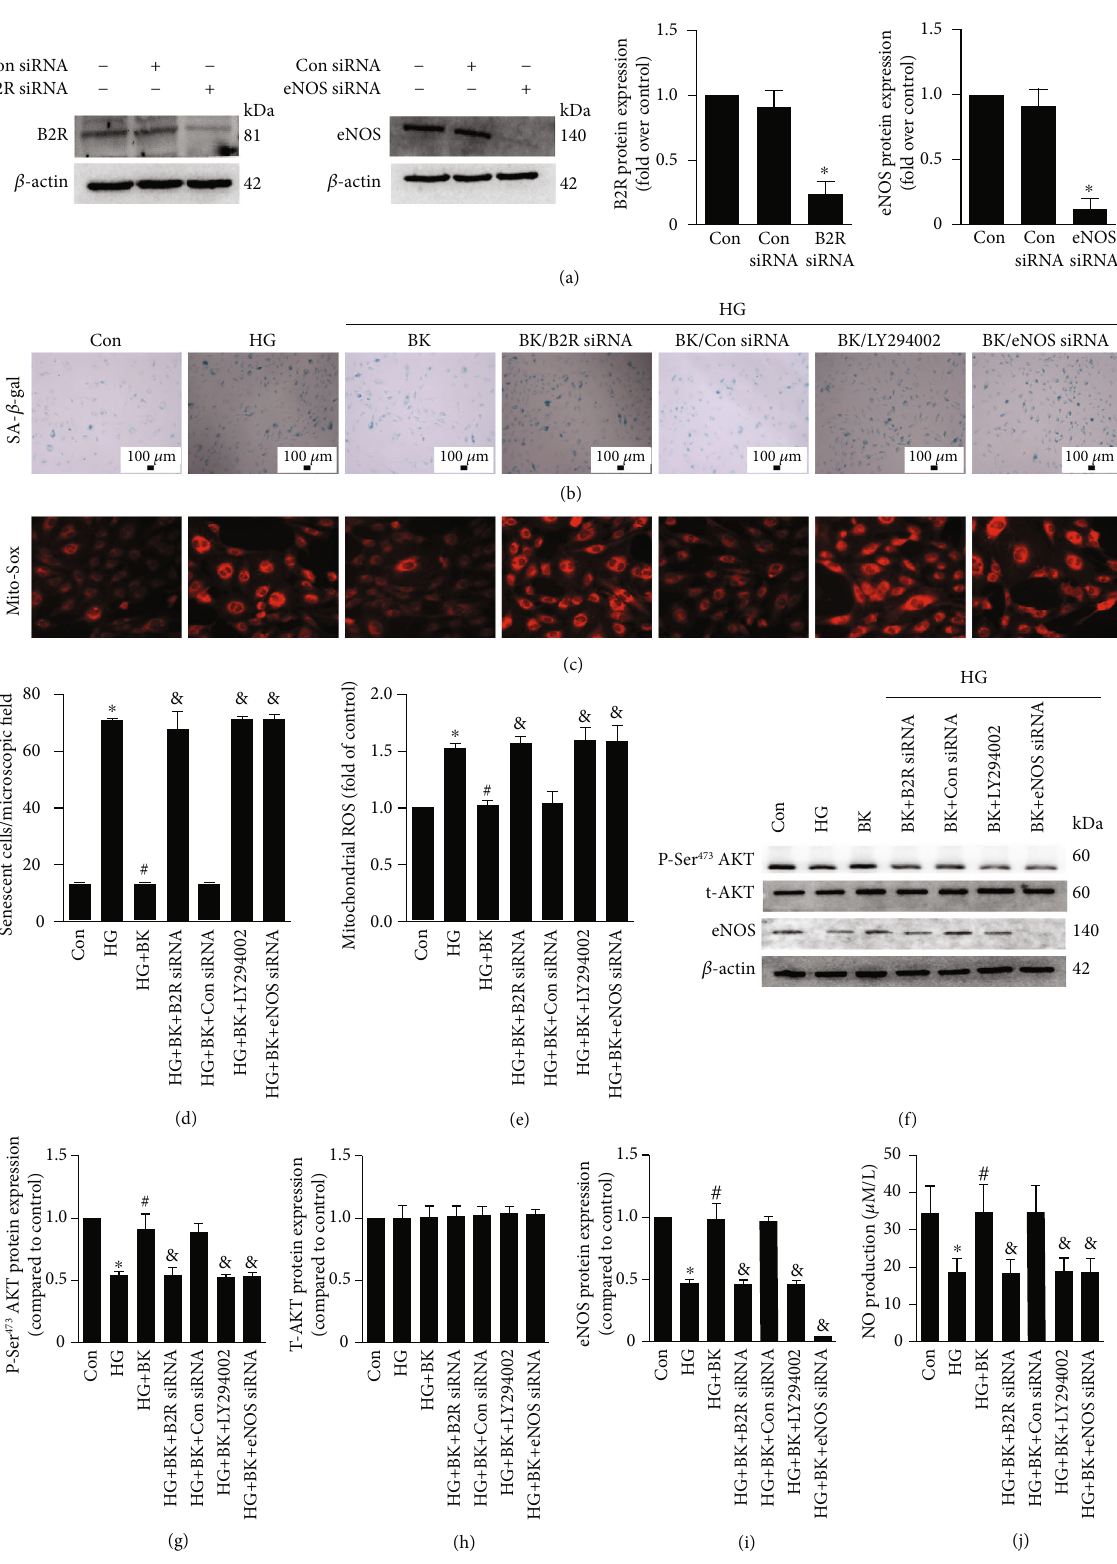
Figure 4: The role of B2R and NO in the protective e ff ect of BK against senescence in EPCs. (a) Western blotting for B2R and eNOS in EPCs. (b) Representative photomicrographs of SA- β -gal staining in EPCs. (d) Number of senescent cells after treatment. (c, e) ROS generation was analysed by Mito-Sox. (f-i) Western blotting for P-Ser 473 AKT, T-AKT, and eNOS in EPCs. (j) NO production was detected by NO assay kit. Bars represent the means ± SD ( ∗ P < 0 : 05 versus control; # P < 0 : 05 versus HG; & P < 0 : 05 versus HG + BK ; n = 6